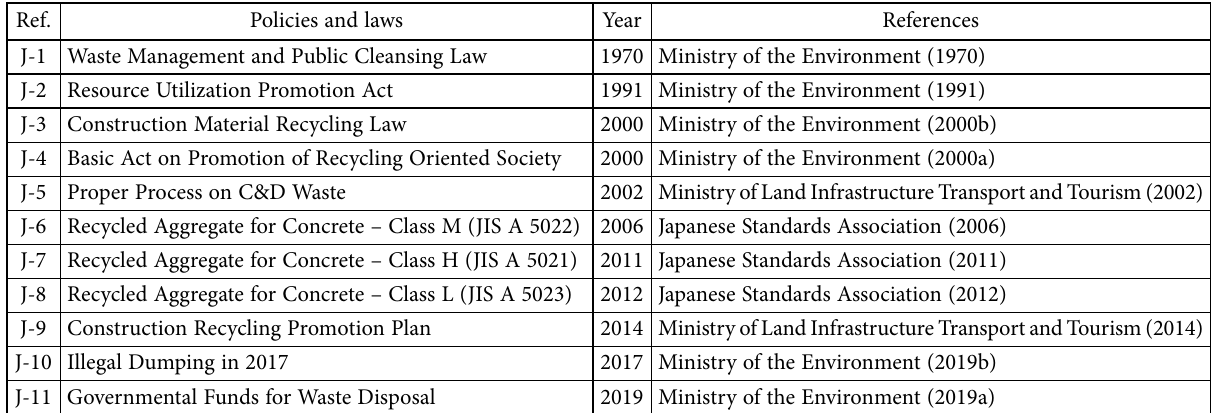
Table 4. Existing policies and laws on C&D waste management in Japan